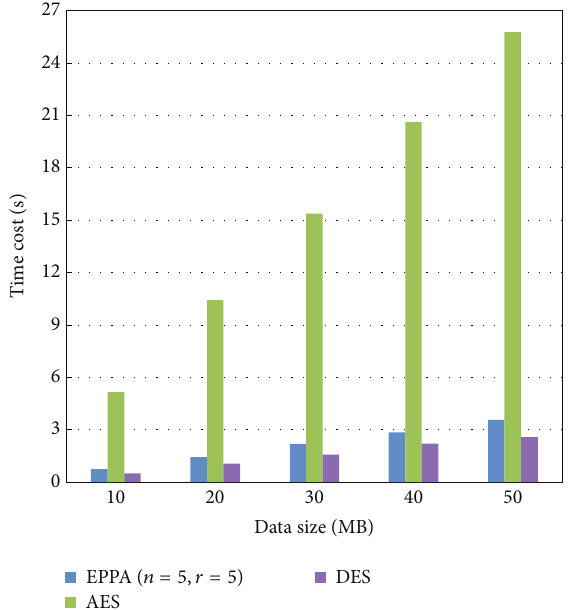
Figure 11: Time cost comparison of EPPA, AES, and DES.